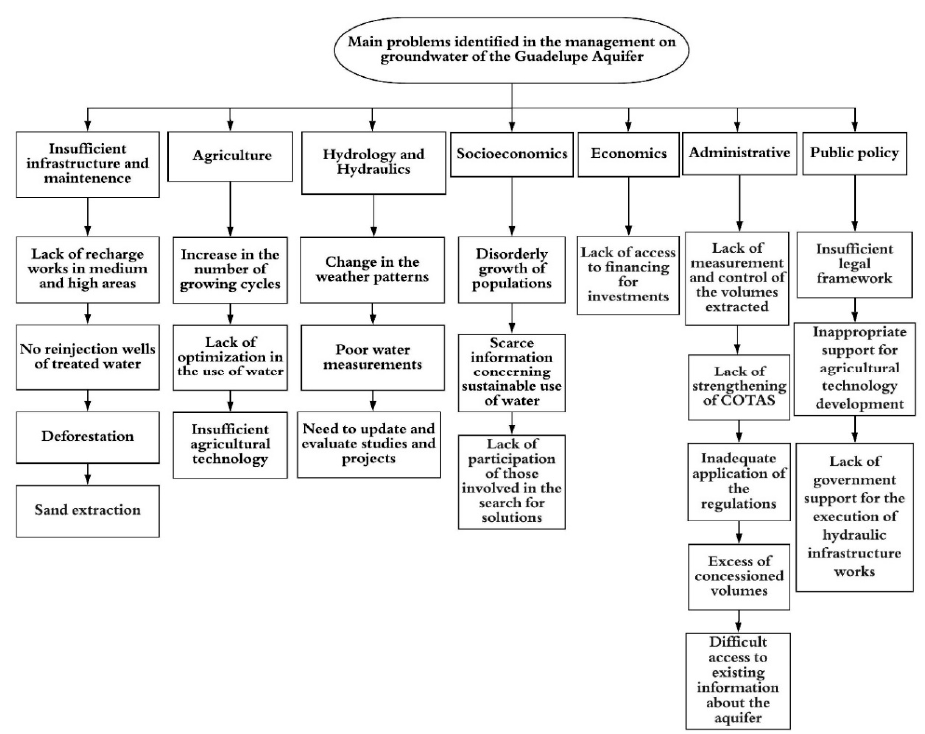
Figure 1. 2007 Groundwater management plan in the Guadalupe Valley aquifer, the issues addressed, and the main problems